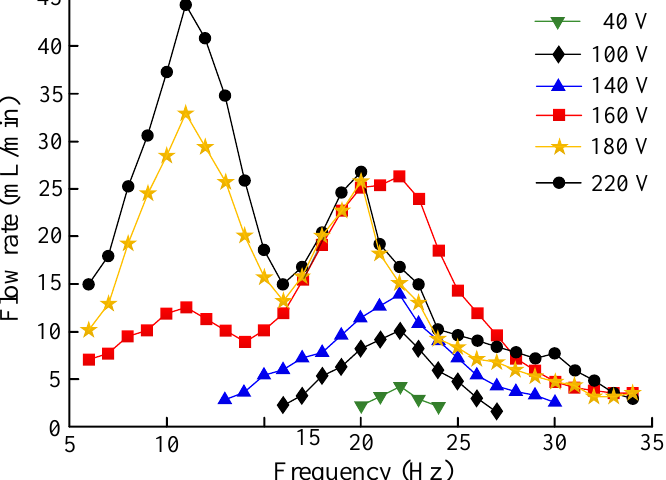
Figure 13. The relationship between the pump-flow rate, the driving voltage, and the driving frequency.